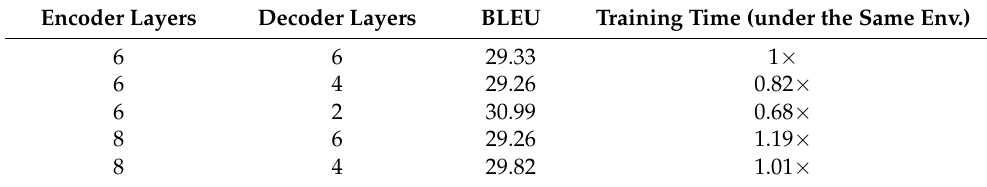
Table 1. Comparison of the number of layers of encoder and decoder in the Transformer